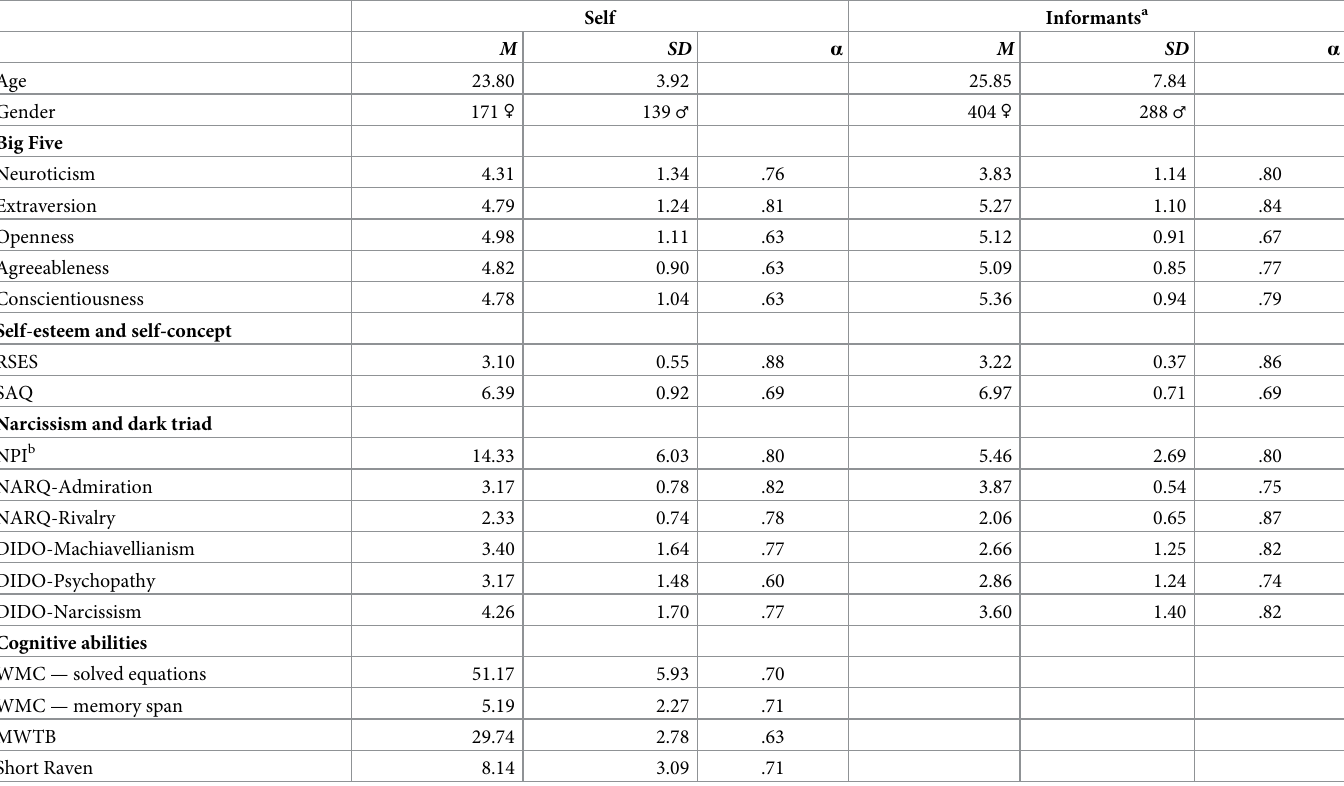
Table 5. PILS selected traits and cognitive abilities. Descriptives.